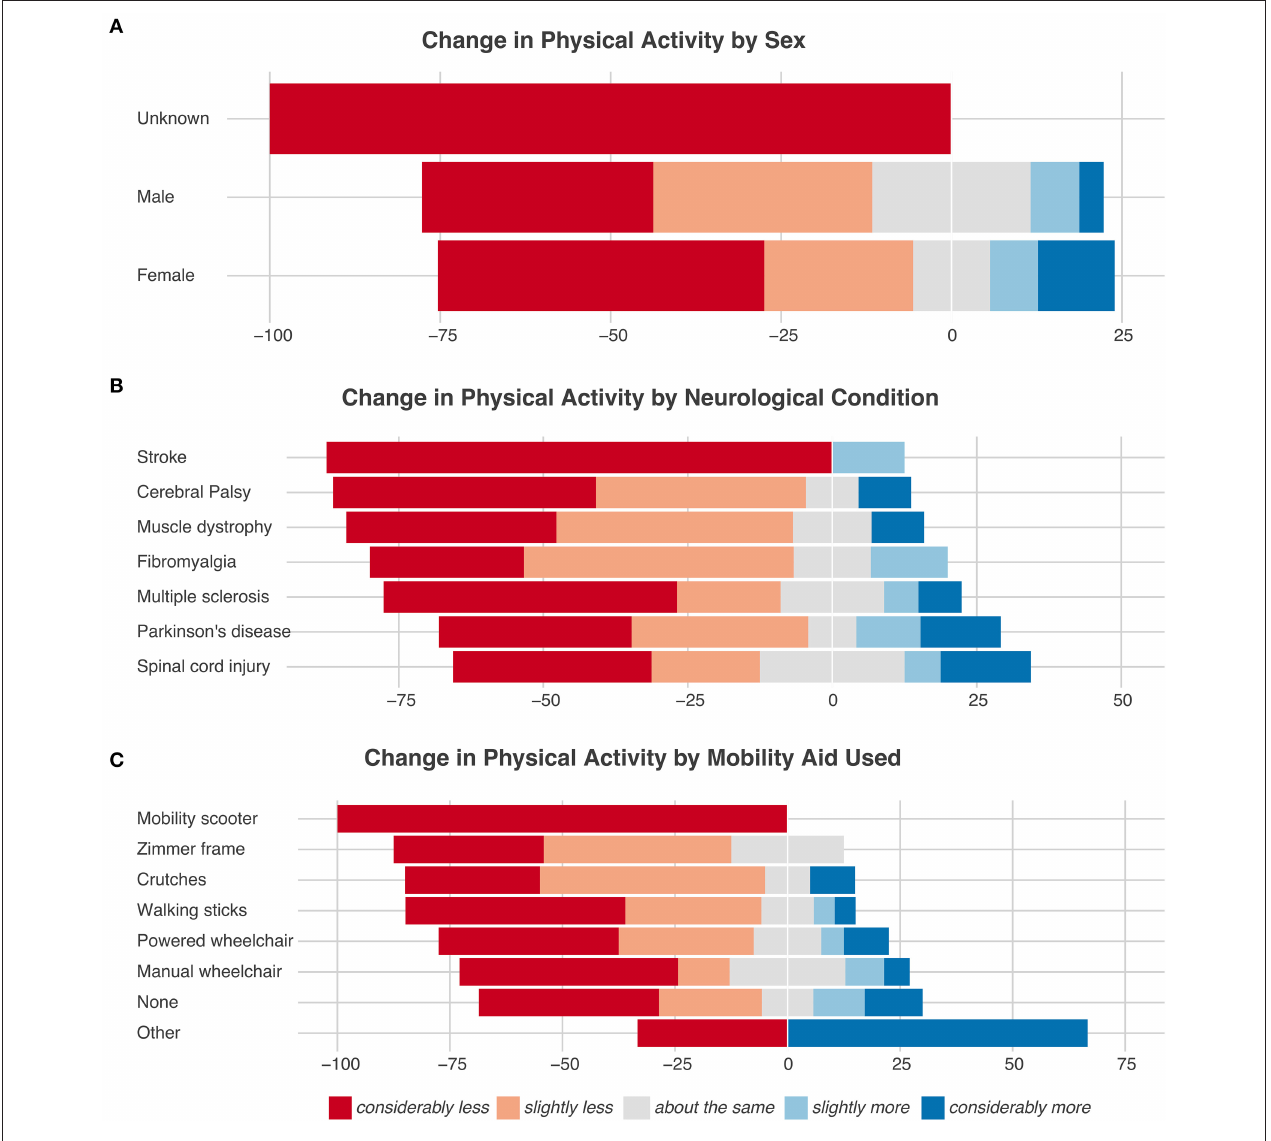
FIGURE 1 | Change in physical activity stratified based on sex (A) , neurological condition (B) , and mobility aid used (C) .